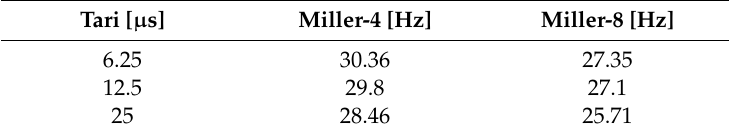
Table 4. Sampling frequency obtained for each combination of Tari value and encoding